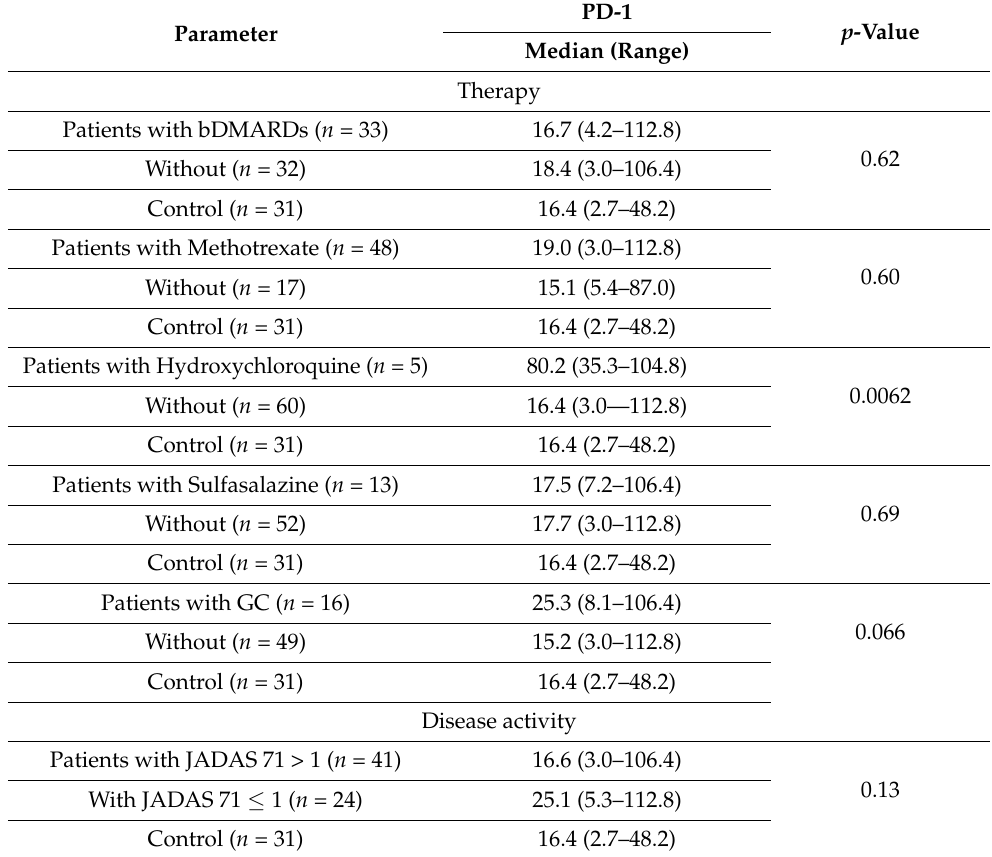
Table 5. Comparison of PD-1 levels depending on the therapy and disease activity (JADAS 71 δ 1 versus JADAS 71 >